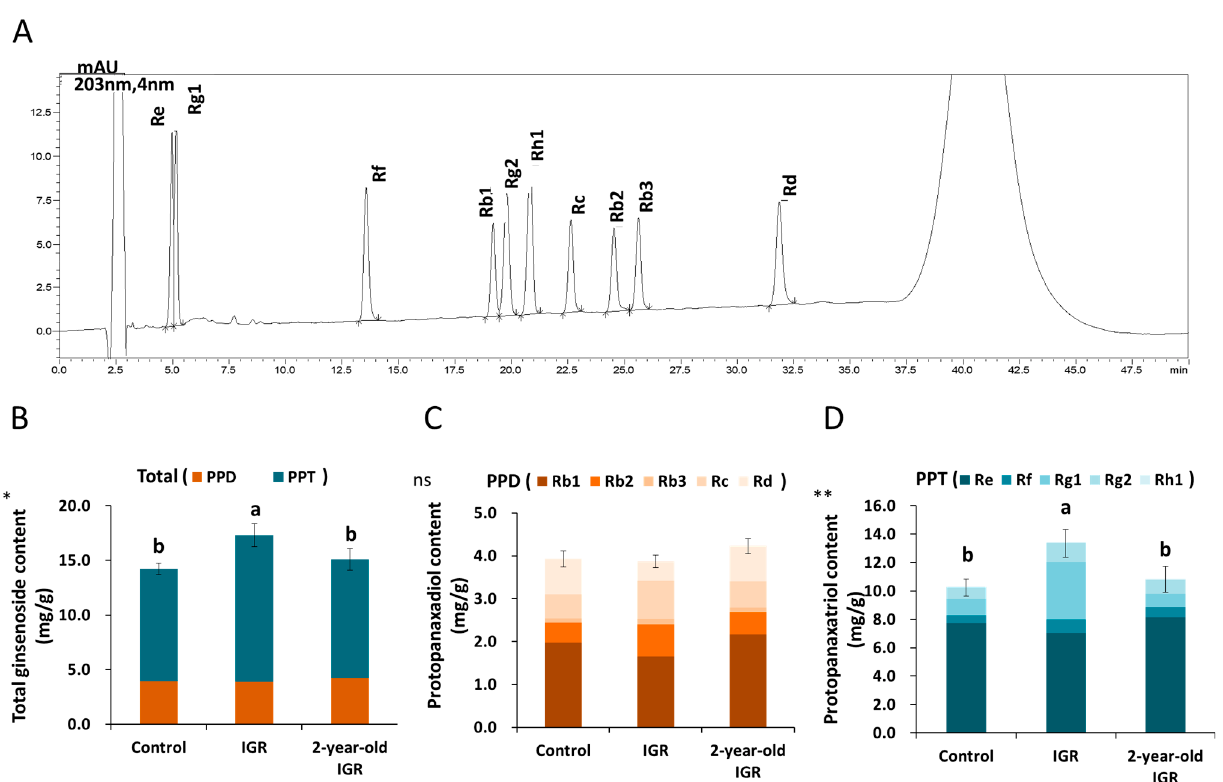
Figure 6. Ginsenoside content of control roots, IGRs, and 2 year old IGRs of P. ginseng . ( A ) Chromatogram of the ten standards. ( B ) Total ginsenoside content. ( C ) PPD-type ginsenoside content. ( D ) PPT-type ginsenoside content. Values represent the means ± standard error of at least three independent experiments, each consisting of 20 roots. ns, *, **: non-significant or significant at p ≤ 0.05 or 0.01 determined by ANOVA. Different letters above each bar represent significant differences ( p ≤ 0.05) based on Duncan’s multiple comparison test. IGR, in vitro-grown root; PPD, protopanaxadiol; PPT, protopanaxatriol. Table 6. Influences of ginsenoside content before and after acclimatization of IGRs as assessed by HPLC analysis.